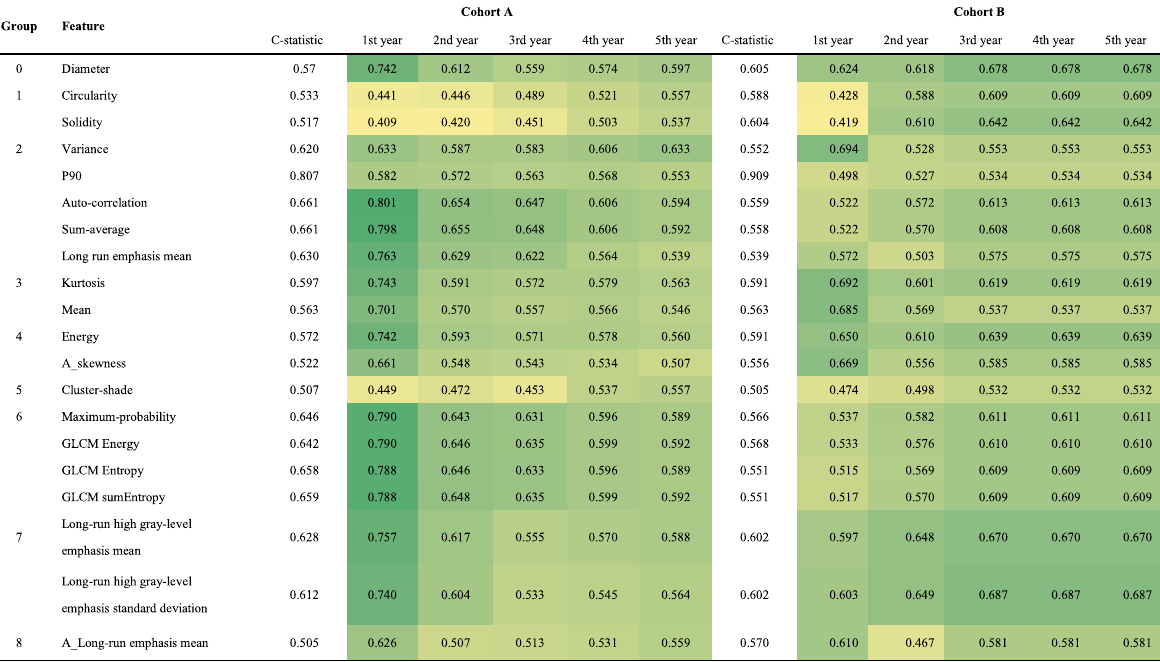
Table 4 Overall and time-dependent performance of single image metrics